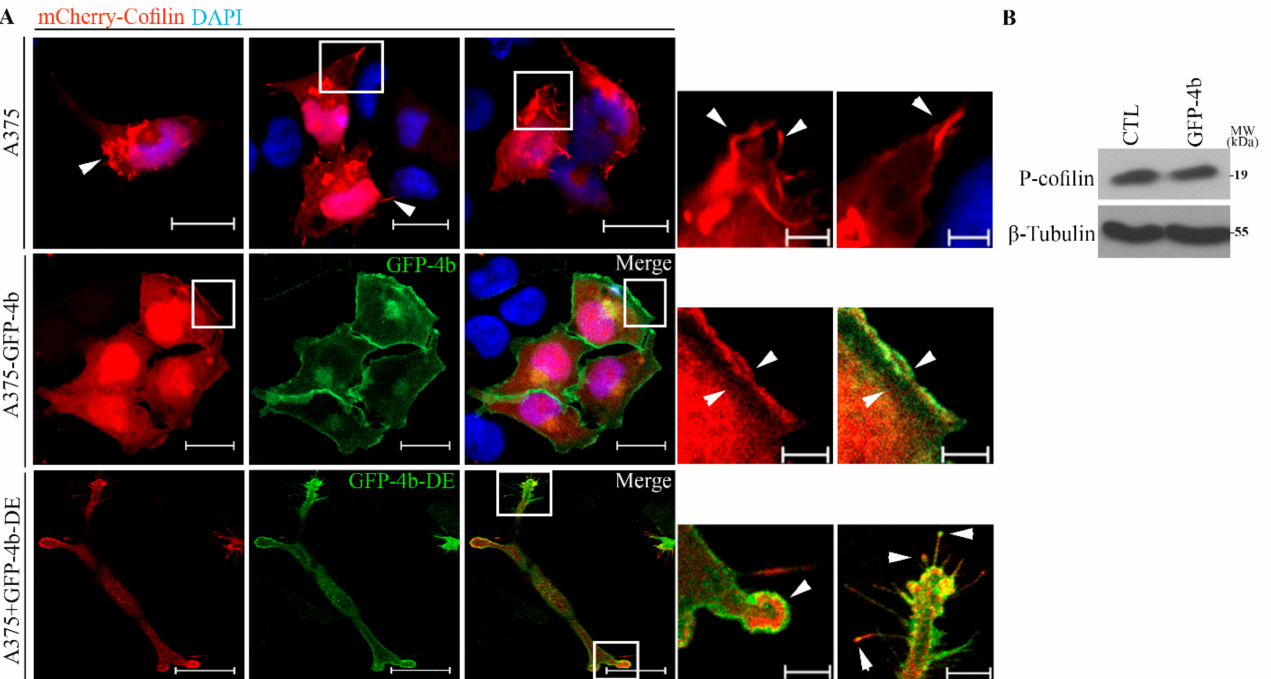
Figure 9. PMCA4b expression results in cofilin reorganization to the leading edge. ( A ) mCherry-Cofilin was transfected in A375 and A375-GFP-PMCA4b cells or cotransfected with GFP-PMCA4bDE in A375 cells. Confocal microscopy images were taken after nuclear staining with DAPI. Scale bar, 20 µ m. Insets show a part of a cell with higher magnification. Arrowheads show the location of expressed cofilin at the leading edge in A375-GFP-PMCA4b cells and filopodia or protrusion in A375 cells and A375 expressing GFP-PMCA4bDE. Scale bar, 5 µ m. ( B ) A375 and A375-GFP-PMCA4b cells were cultured in a 6-well plate for 48 h. Endogenous P-cofilin protein expression from total cell lysate was analyzed by Western blotting. β -tubulin was used as a loading